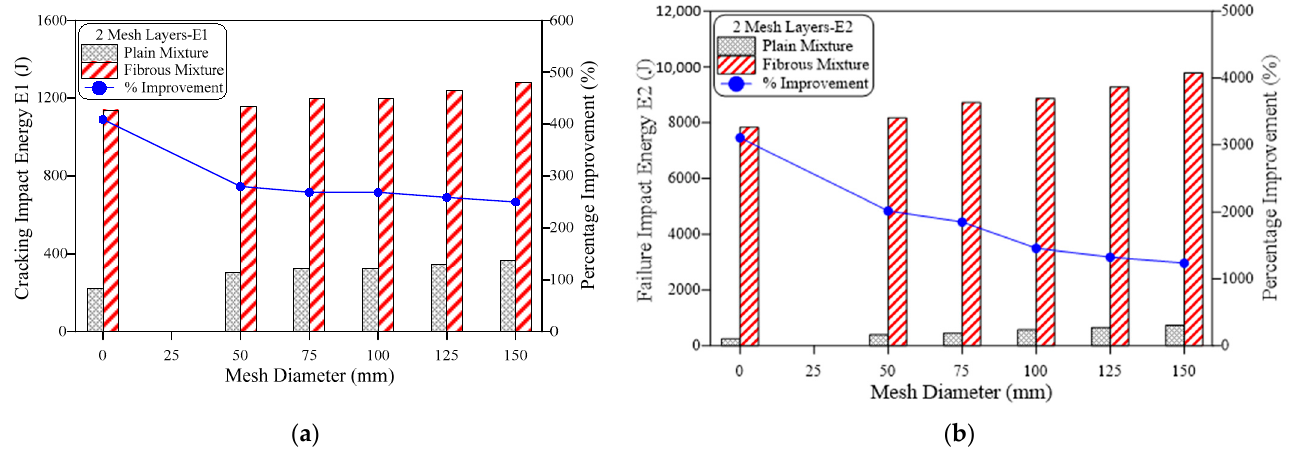
Figure 10. Effect of fiber on the impact energy of mixtures with 2-mesh layers, ( a ) cracking energy E1, ( b ) failure energy E2.